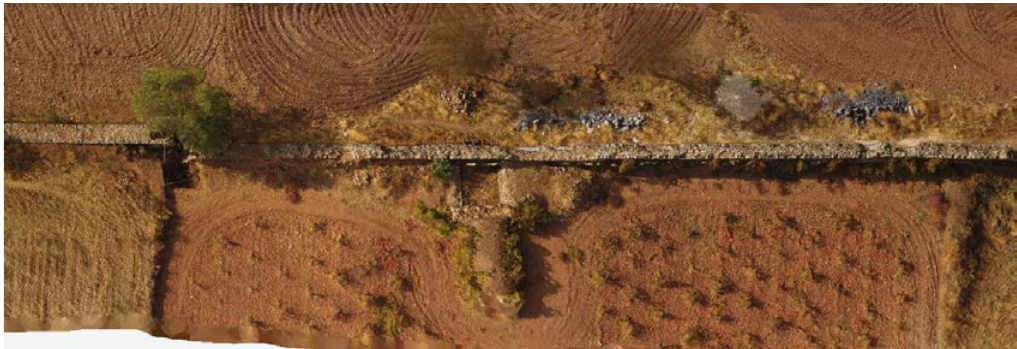
Figure 9. 3D mesh of Roman dam section generated from captured drone-based